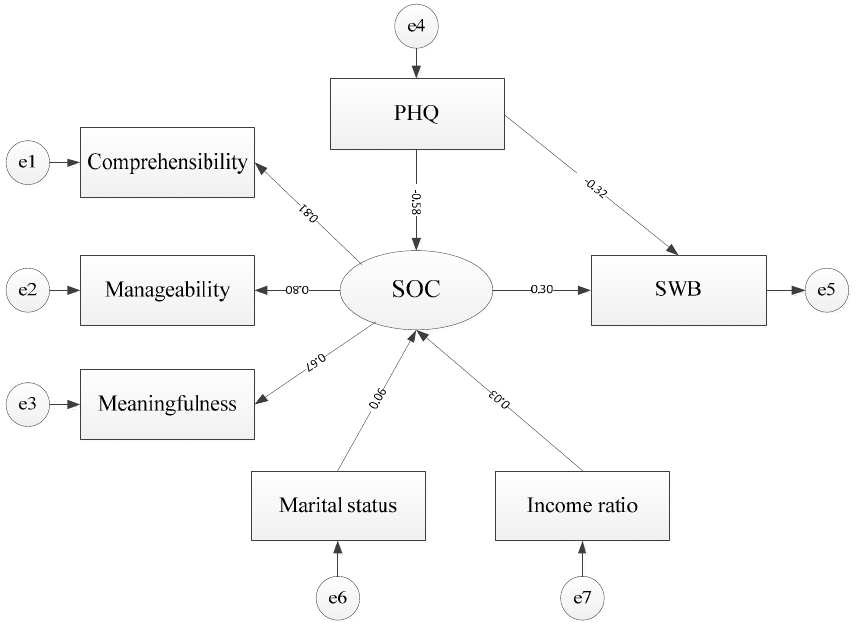
Figure 2. The paths among PHQ, SOC, GRRs, and SWB. (e1–e7: residuals of observed variables)